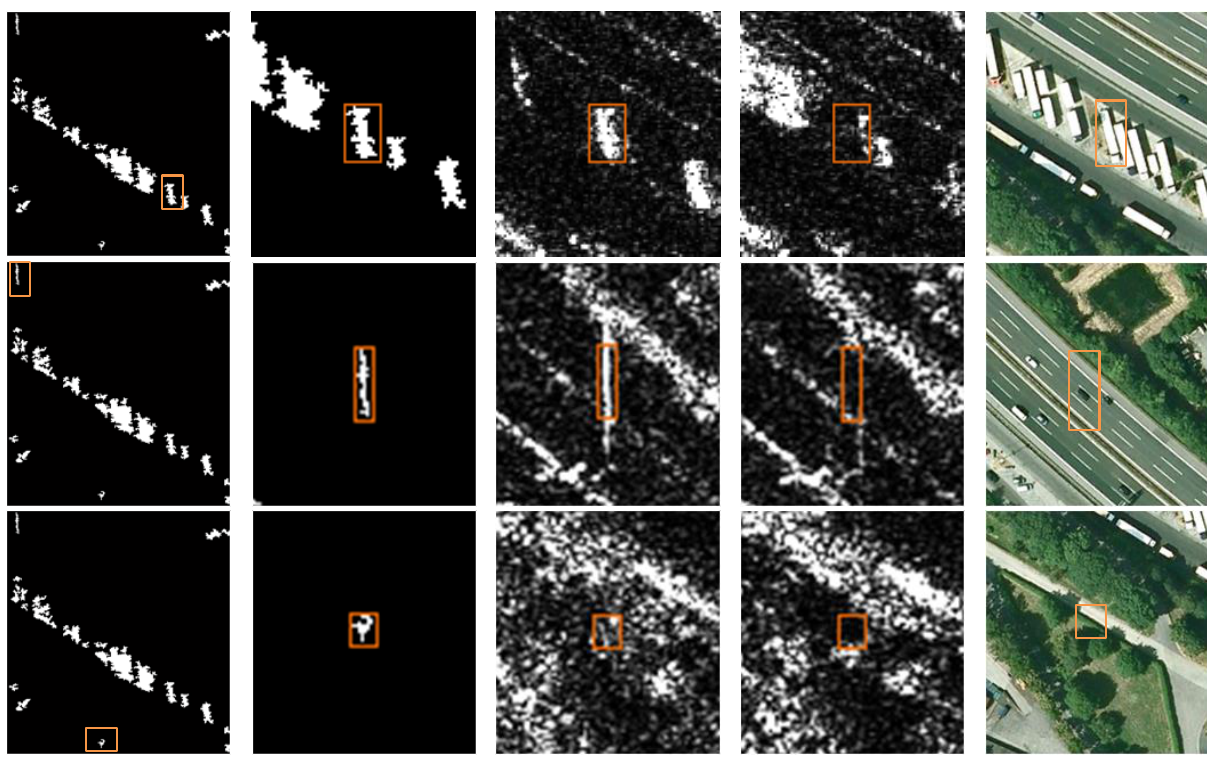
Figure 2: Matching change segments to Figure 1. Upper row: Change segment on highway parking place; center row: Moving target change segment; Lower row: Other change segment. From left to right: Location of change segment in subset of CM, change segment zoom-in, amplitude image subset t 1 , amplitude image subset t 2 , location of change segment in Google Earth